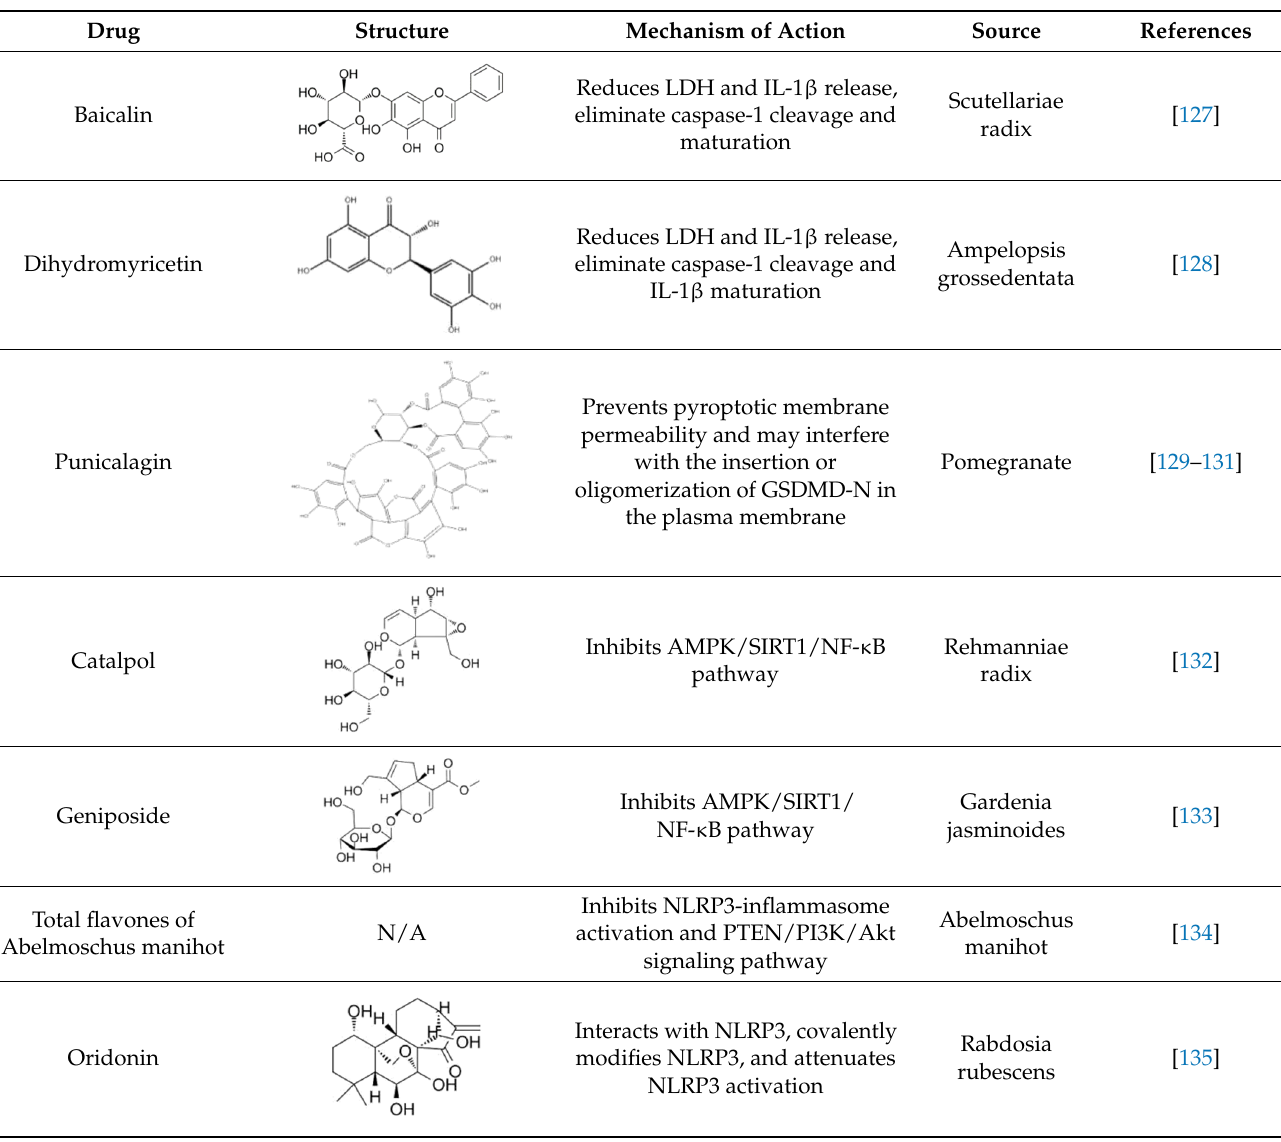
Table 4. Natural products as inhibitors of pyroptosis.